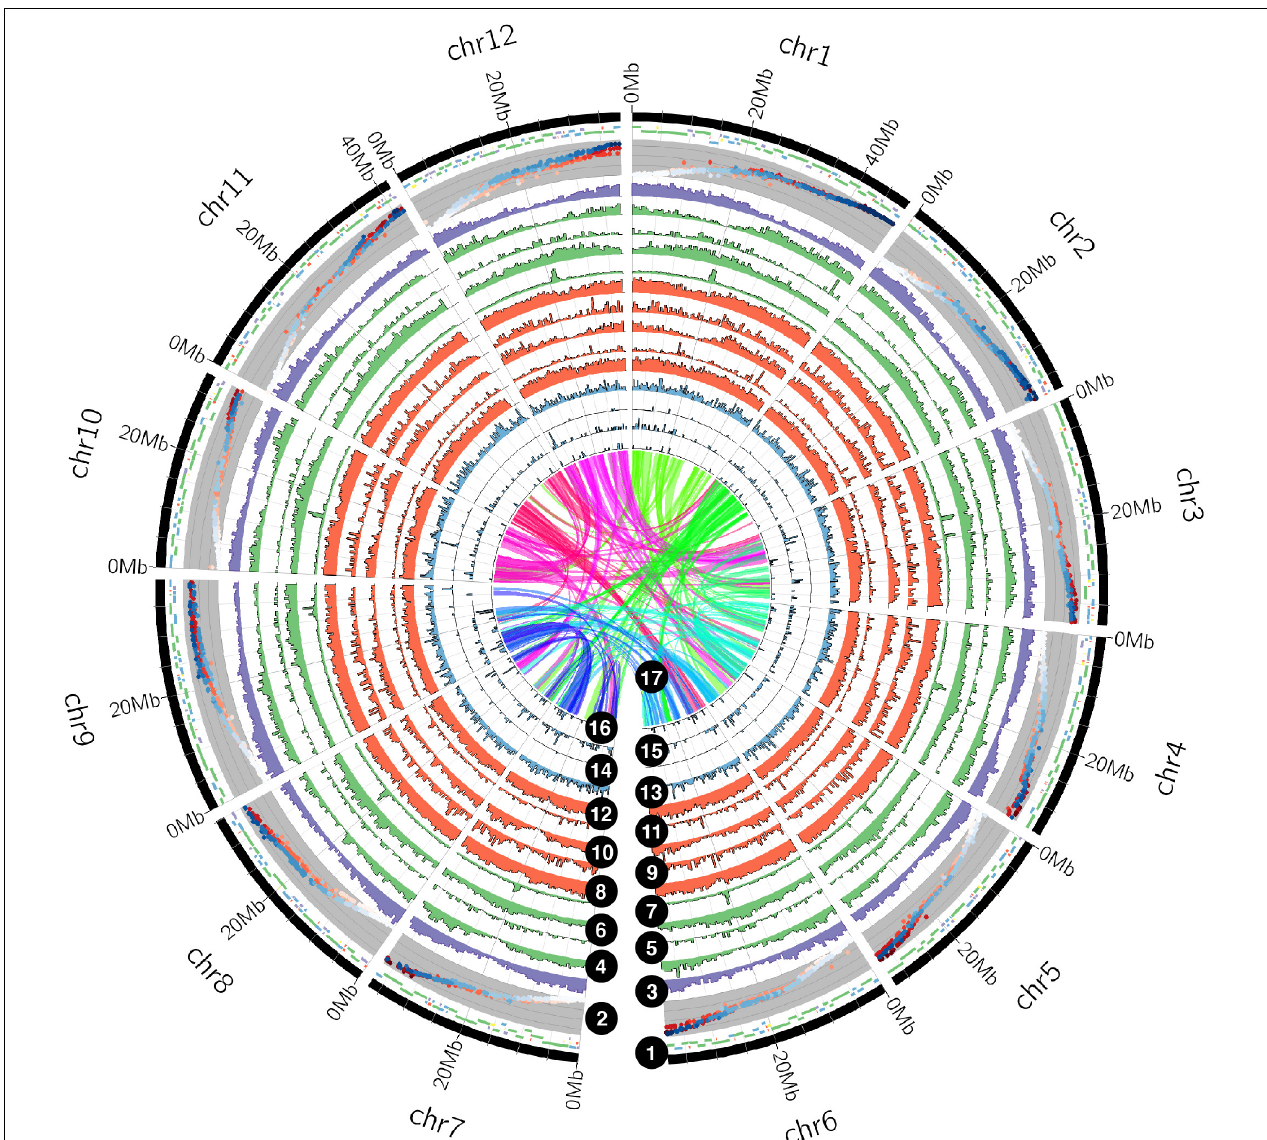
FIGURE 1 | The American cranberry ( Vaccinium macrocarpon Ait.) genome multidimensional landscape. Rings, from outside to inside, correspond to: (1) the tile plot depicts the anchored scaffolds into the final cranberry genome assembly, colored by the number of markers used for ordering and orienting (green > 10, blue > 5, purple > 2, yellow = 2, and red = 1); for visualization purposes, tiles are displayed among three concentric layers, however, there is no overlapping between them; (2) four overlapped scatter plots displaying genetic distances for the parental linkage maps used for scaffolding (CNJ02 and GRYG populations colored in red and blue, respectively); (3) gene density in 500 Kb non-overlapping bins; repeat density (500 Kb non-overlapping bins) by type, as follows: (4) SINEs, (5) ERVs, (6) LTR elements, (7) LINEs, (8) simple repeats, (9) satellites, (10) small RNAs (predicted by RepeatMasker), (11) rolling circles, and (12) DNA elements; non-coding RNA density (in 500 Kb non-overlapping bins) by type, as follows: (13) microRNAs, (14) tRNAs, (15) rRNAs, and (16) snoRNAs (predicted by Infernal). Links within and between chromosomes represent cranberry collinear blocks